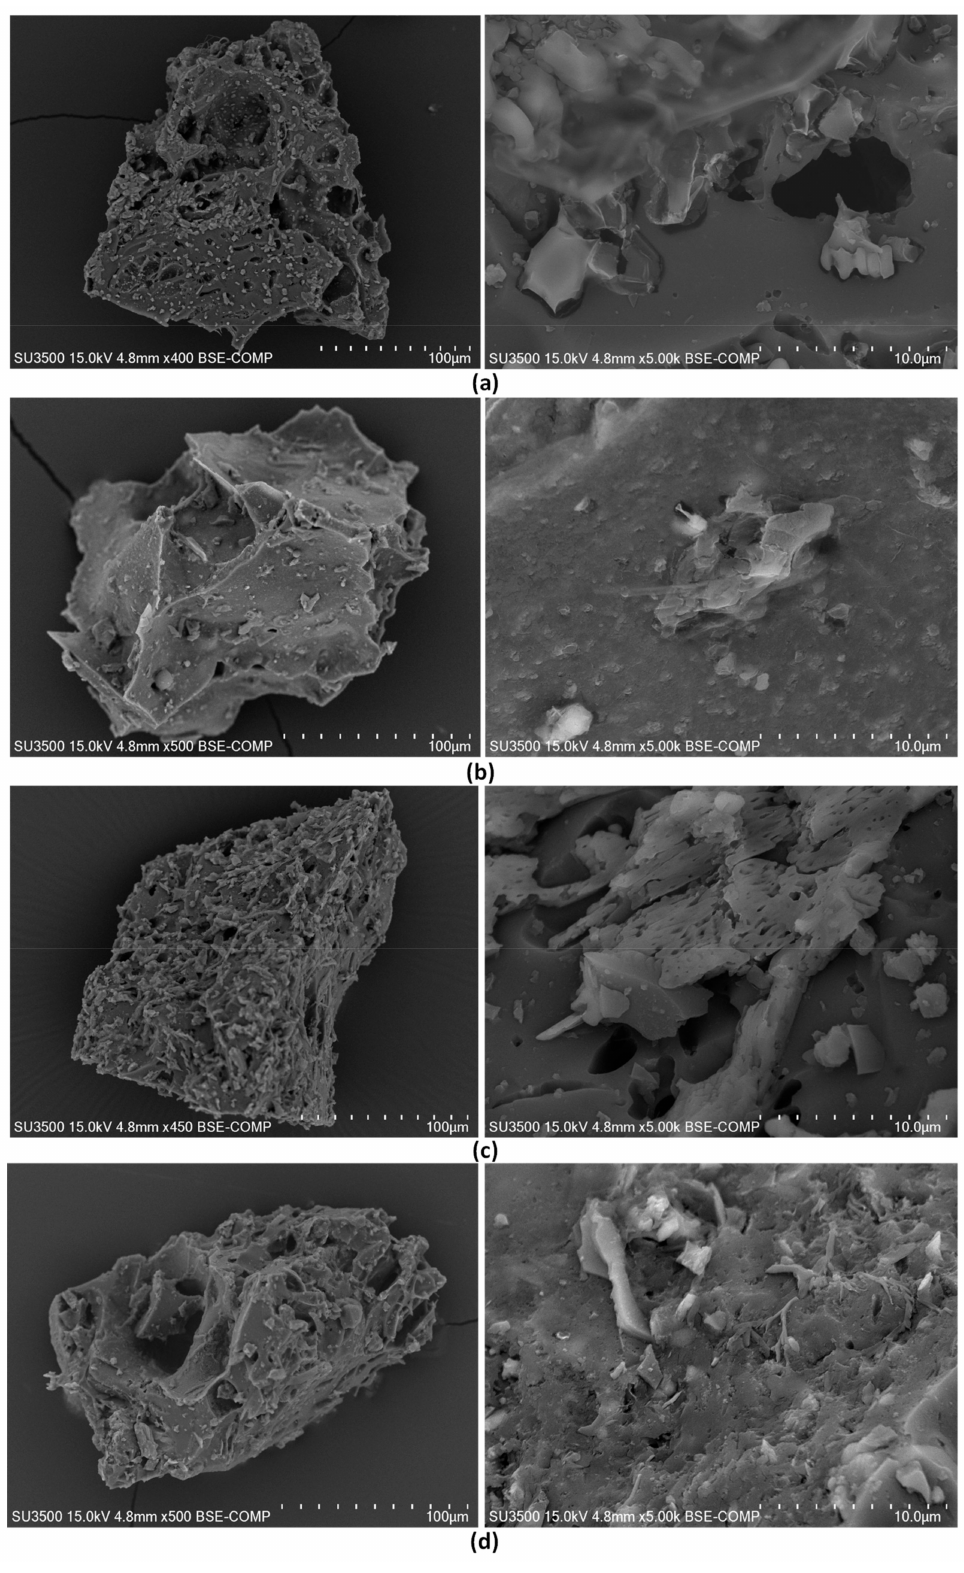
Figure 6. Scanning electron microscopy (SEM) images of olive pomace-derived carbon materials produced at 800 ◦ C, under carbon dioxide atmosphere and pressure of: ( a ) 0.1 MPa, ( b ) 1 MPa, ( c ) 2 MPa, and ( d ) 3